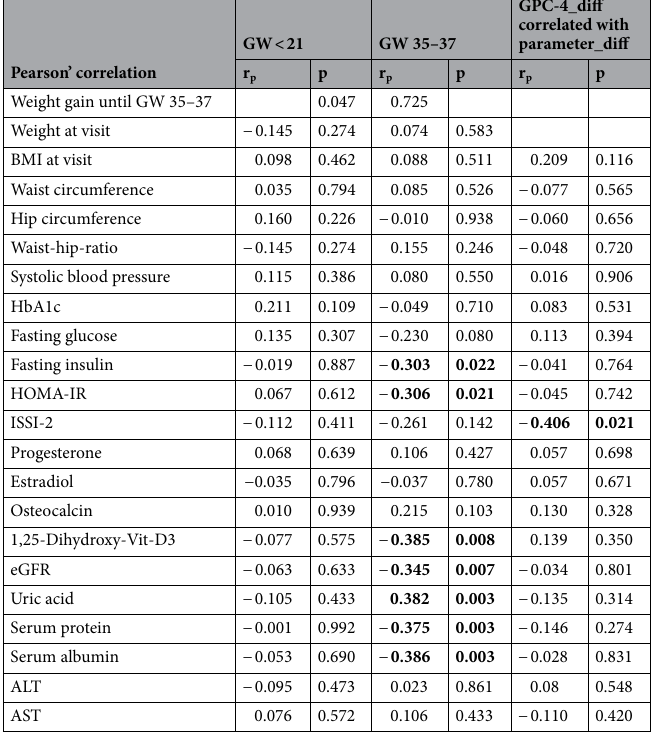
Table 2. Pearson’s correlation analysis of GPC-4 levels during pregnancy at GW < 21 and GW 35–37 as well as the difference in GPC-4 levels (GPC4_diff) correlated with the change in parameters (parameter_diff) from GW < 21 to GW 35–37. Significant values are in bold. HOMA-IR homeostasis model assessment for insulin resistance, ISSI-2 insulin secretion sensitivity index, HbA1c hemoglobin A1c, 1,25-Dihydroxy-Vit-D3, eGFR estimated glomerular filtration rate, AST aspartate aminotransferase, ALT alanine aminotransferase. Significance level is p <